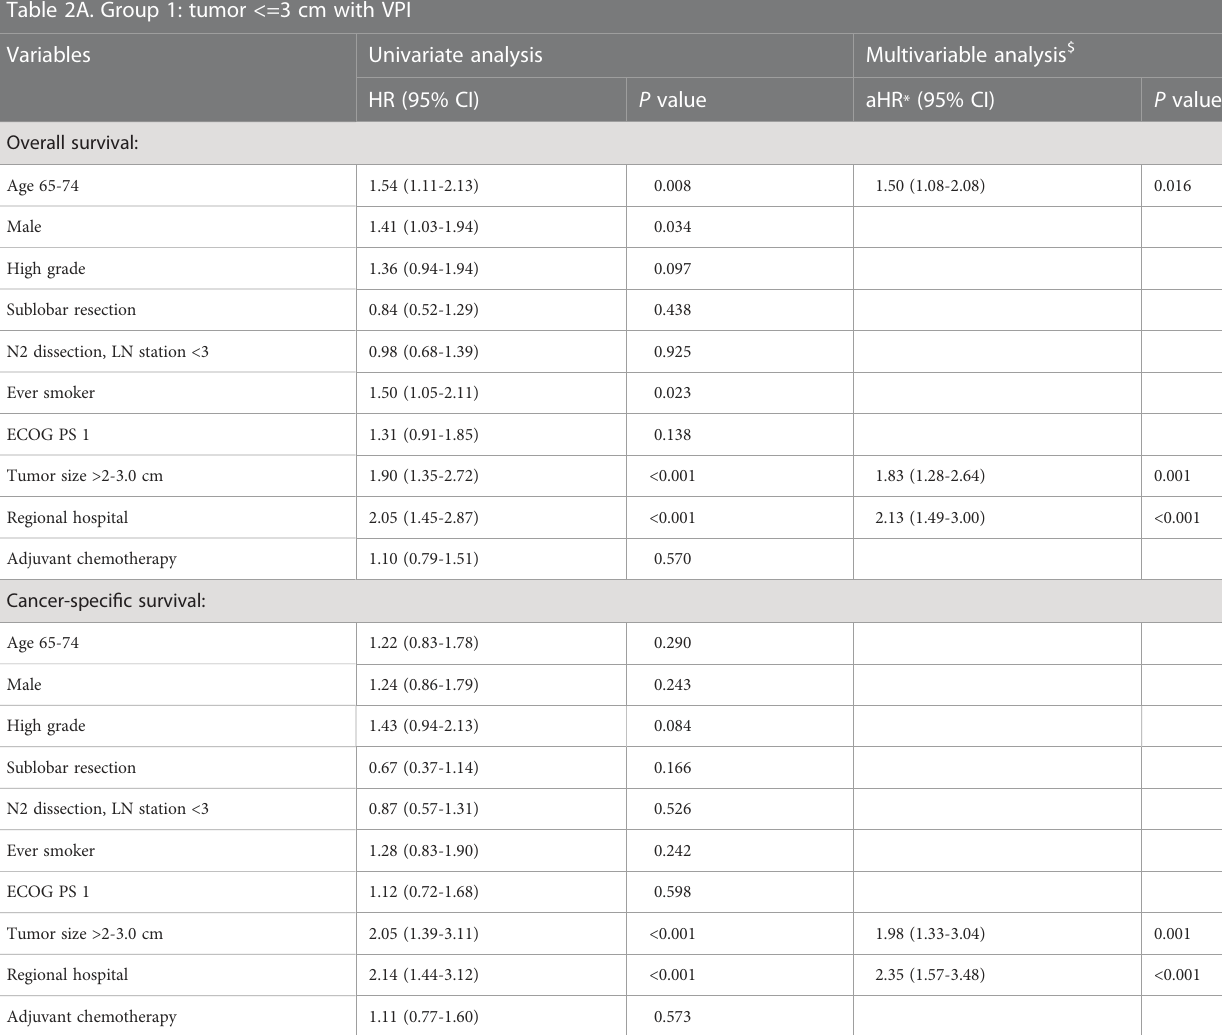
TABLE 2A Univariate and multivariable analysis for (A) overall survival (OS) and cancer-speci fi c survival (CSS) of Group 1: tumor <=3 cm with VPI; and for (B) OS and CSS of Group 2: tumor >3-4 cm. Table 2A. Group 1: tumor <=3 cm with VPI